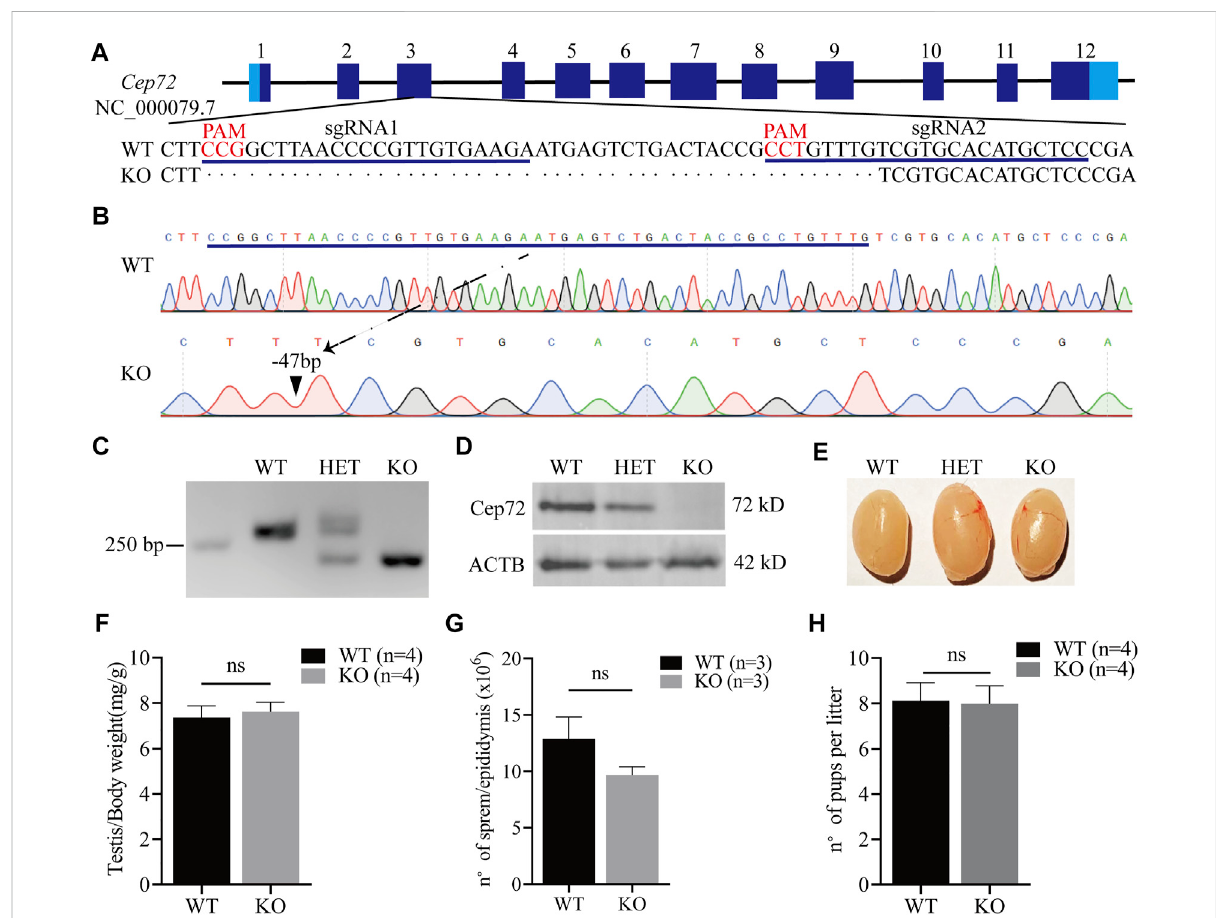
FIGURE 2 LossofCep72 doesnotimpair thefertilityofmice. (A) Targetingstrategy of Cep72 KOmice usingCRISPR/Cas9technology.Boxes areexons of the Cep72 gene (NC_000079.7), while the dark and light blue boundaries represent where the start (1) and stop (12) codons are located. The blue lines display two designed sgRNAs, and the red mark shows the PAM (protospacer adjacent motif) of sgRNAs. (B) Results of Sanger sequencing showing 47 bp deletion from Cep72 KO and WT mice. The blue line represents the missing sequence. The dashed line and black triangle indicate the position of the lost sequence in Cep72 KO mice. (C) Representation of PCR genotyping, and 250 bp is the location of the marker. WT, wildtype(265 bp); HET, heterozygous;KO, knockout (218 bp);2%agarose gel. (D) Westernblotresults demonstratingtheCep72proteinexpression inthetestis of10-week-old WT,HET, and Cep72 KOmice. ACTB servedasan internalcontrol. (E) Morphology ofthetestis of10-week-old WT,HET, and Cep72 KO mice. (F) Testis to body weight ratio of 10-week-old WT and Cep72 KO mice. Data are presented as mean ± SEM, n = 4; ns: no signi fi cant difference. (G) Sperm number per epididymis of 10-week-old WT and Cep72 KO mice. Data are presented as mean ± SEM, n = 3; ns: no signi fi cant difference. (H) Number of pups per litter from WT and Cep72 KO male mice. Data are presented as mean ± SEM, n = 4; ns: no signi fi cant